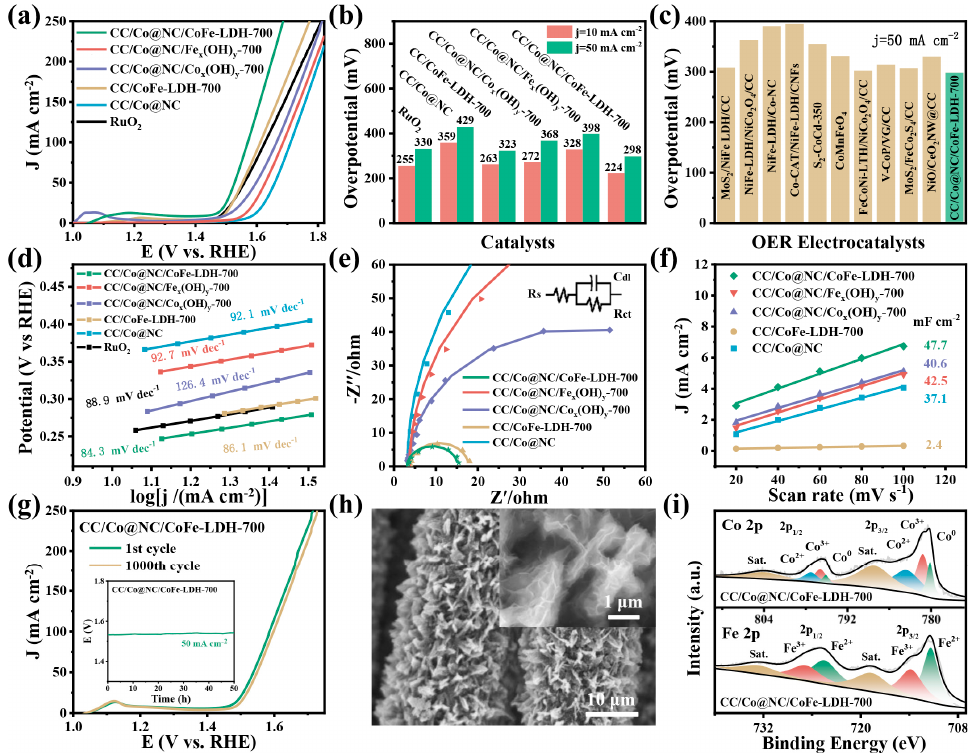
Figure 4. OER performance of the as-prepared samples. ( a ) LSV Polarization curves at a scan rate of 2 mV/s. ( b ) Comparison of overpotentials at the current density of 10 mA cm − 2 ( η 10 ) and 50 mA cm − 2 ( η 50 ). ( c ) Comparison of overpotentials at the current density of 50 mA cm − 2 between CC/Co@NC/CoFe-LDH-700 and other recently reported OER electrocatalysts. ( d ) Tafel plots. ( e ) Nyquist plots and the inset shows the equivalent circuit. ( f ) The C dl obtained from the CV curves. ( g ) Polarization LSV curves before and after 1000 CV cycles, and the inset shows a chronopotentiometry curve at a constant current density of 50 mA cm − 2 for 50 h. ( h ) SEM images and ( i ) XPS spectra of Co 2p and Fe 2p for CC/Co@NC/CoFe-LDH-700 after stability measurement.